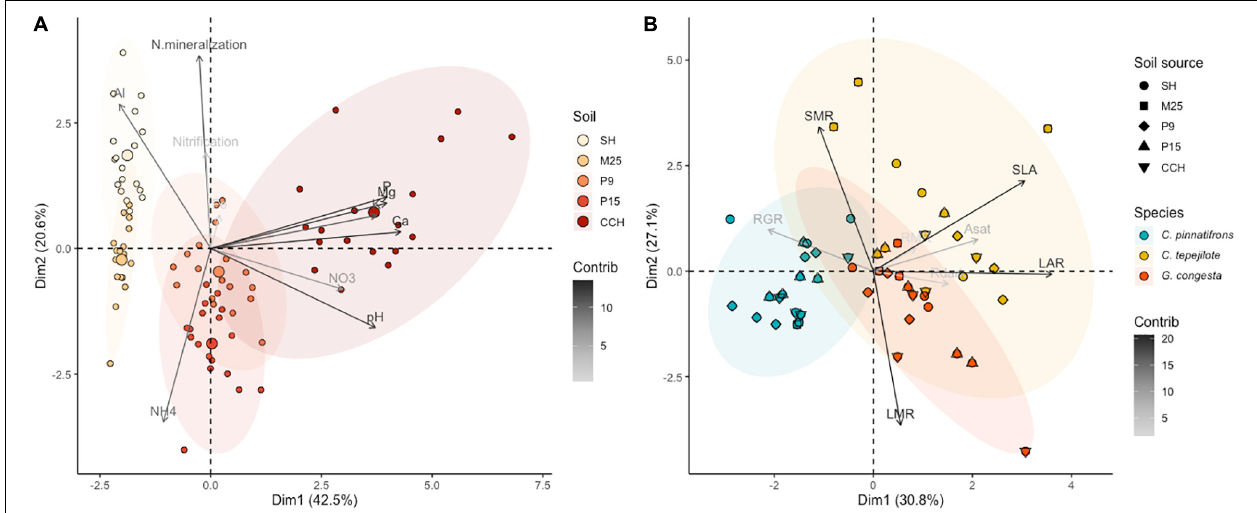
FIGURE 1 | (A) Principal component analysis of soil data for each of the five sites, SH, M25, P15, P9, and CCH. Each point represents a separate sample ( n = 90) and shading represents increasing soil nutrient availability from SH to the CCH site. Contribution of soil properties, AL, Ca, Fe, K, Mg, P, NH 4 , NO 3 , N mineralization, Nitrification, and pH, are indicated by arrow shading. Concentration ellipses are displayed for each of the five soils. (B) Principal component analysis of seedling trait data for three species at each of the five sites, with each point representing a separate sample ( n = 59). Contribution of seedling traits are indicated by arrow shading. Concentration ellipses are displayed for each of the three species. The primary seedling trait ordination axis (PC 1) represents a shift from high relative growth rate (RGR) to investment in high leaf quality, specific leaf area (SLA), leaf area ratio (LAR), root mass ratio (RMR), maximum photosynthetic rate (A sat ), and dark respiration rates ( R dark ). The secondary seedling trait ordination axis (PC 2) represents a shift from high leaf mass ratio (LMR) to high stem mass ratio